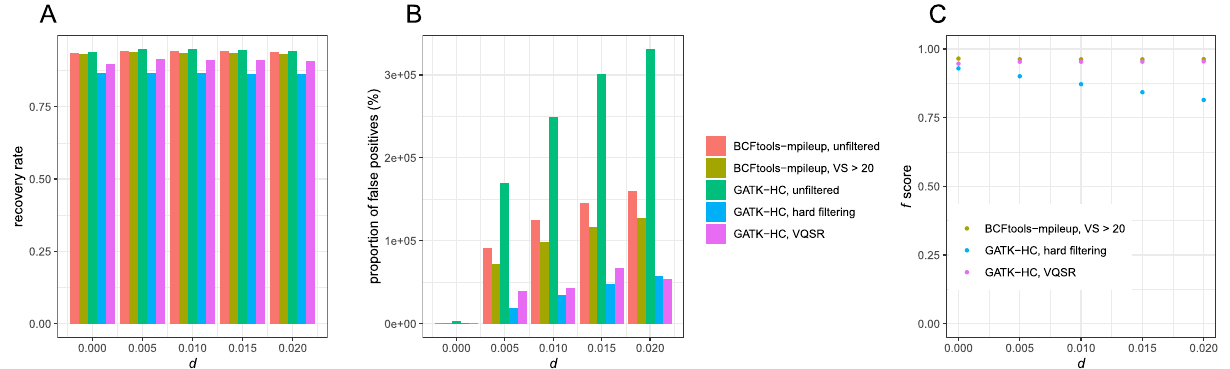
Figure 5. Variant calling performance using bwa-mem ( A ) The recovery rate, ( B ) the proportion of false positives, and ( C ) f scores of SNV datasets generated by Bcftools or GATK.